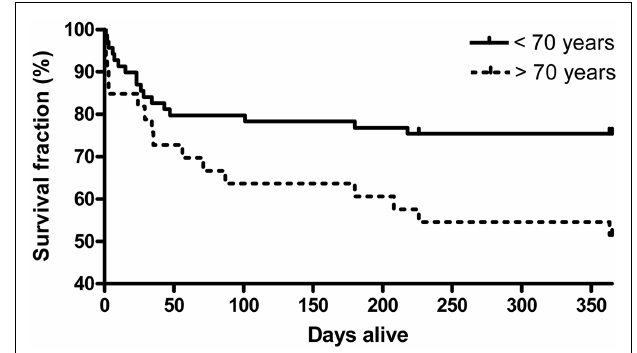
Table 3 | Risk factors for negative outcome in severe sepsis and septic chock*, univariate analysis with cox proportional hazards regression .